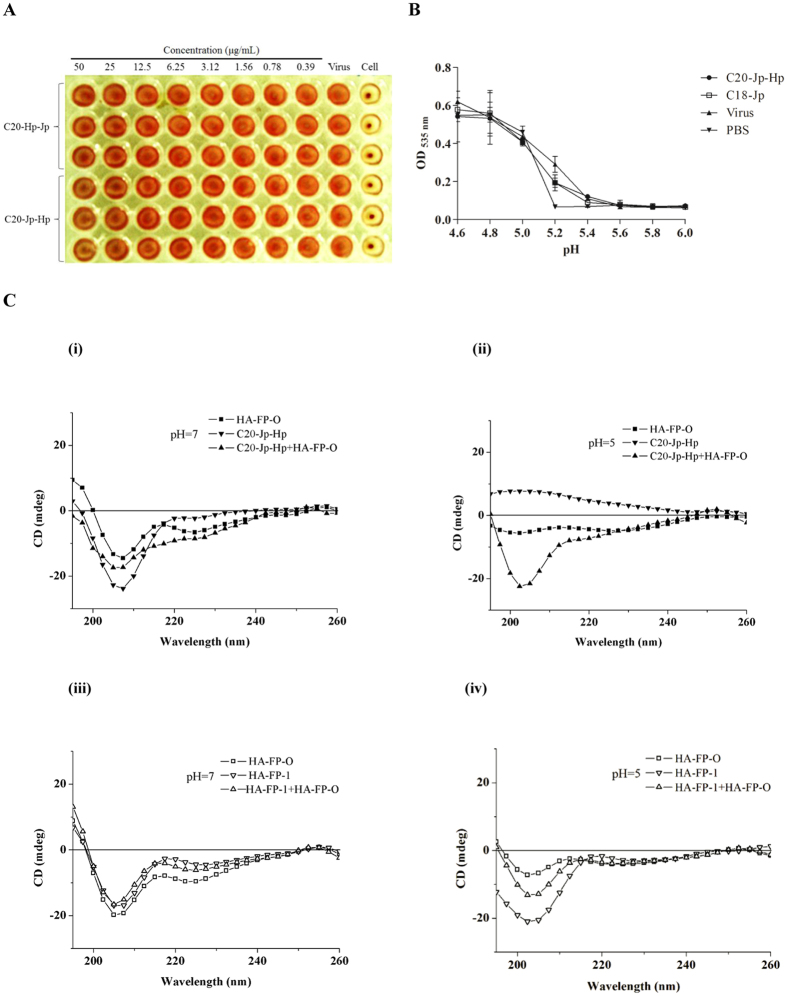
(A) The inhibitory effect of peptides on viral adsorption into target cells. Hemagglutination inhibition (HI) assay was performed using 4 times the HA units (4HAU) of virus per well. 25 μL of peptides from a twofold serial dilution in saline was added into 25 μL virus (4HAU), following the addition of 50 μL of erythrocytes (0.5% v/v in saline) into each well. The hemagglutination reaction results were read after incubation for 1 h. PBS without virus was used as positive control, while virus only as negative control. (B) Hemolysis inhibition assay. Peptide (10 μM) in PBS was mixed with the influenza virus A/PR/8/34 (H1N1) strain. 200 μL of 2% chicken erythrocytes pre-warmed at 37 °C was then added. After incubation at 37 °C for another 30 min, 100 μL of sodium acetate (0.5 M; pH 4.6–6.0) was added and mixed with the erythrocyte suspension to trigger hemolysis. After incubation for 30 min, the mixture was centrifuged and the supernatants containing released hemoglobin were measured at OD535. (C) The interactions between C20-Jp-Hp and HA-FP-O analyzed with circular dichroism (CD) spectra. (i) C20-Jp-Hp interacted with HA-FP-O in PBS (pH 7.4) and (ii) acidic condition (pH 5.0); (iii) HA-FP-O mixed with HA-FP-1 in PBS (pH 7.4) and (iv) in acidic condition (pH 5.0). CD curves of individual or mixed peptides with equimolar concentrations were scanned from 195 to 260 nm with an average of four scans.